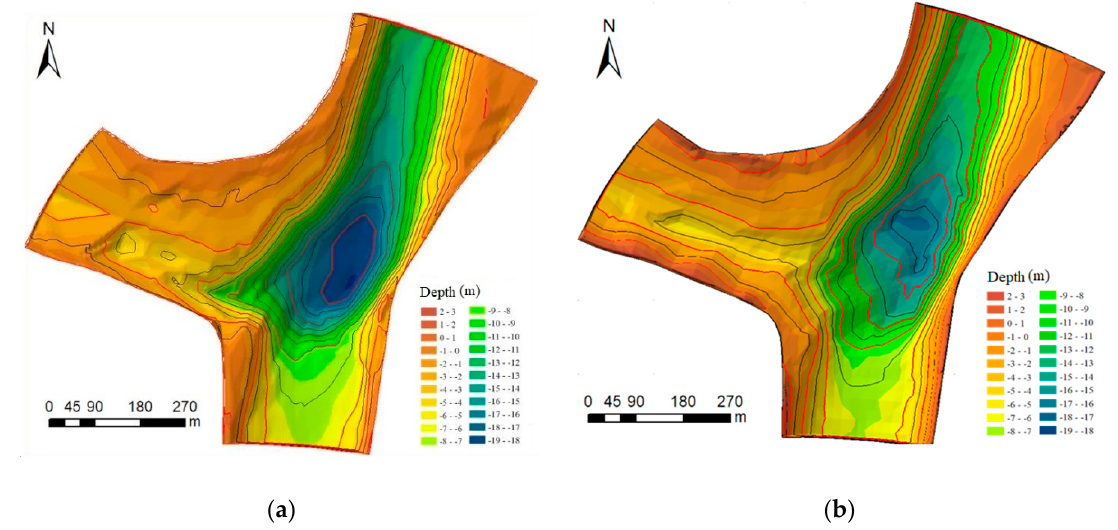
Figure 8. Measured bathymetry of a tidal confluence: ( a ) 2010; ( b ) 2015 (adapted from Xie [80] ) .